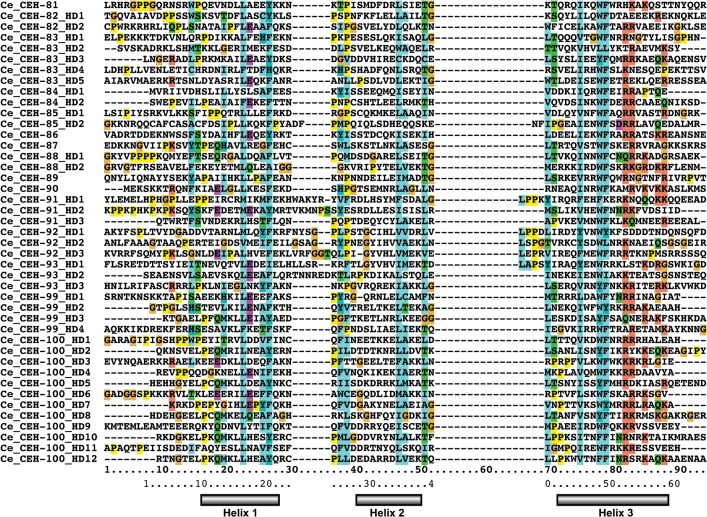
Second part of Fig 4.